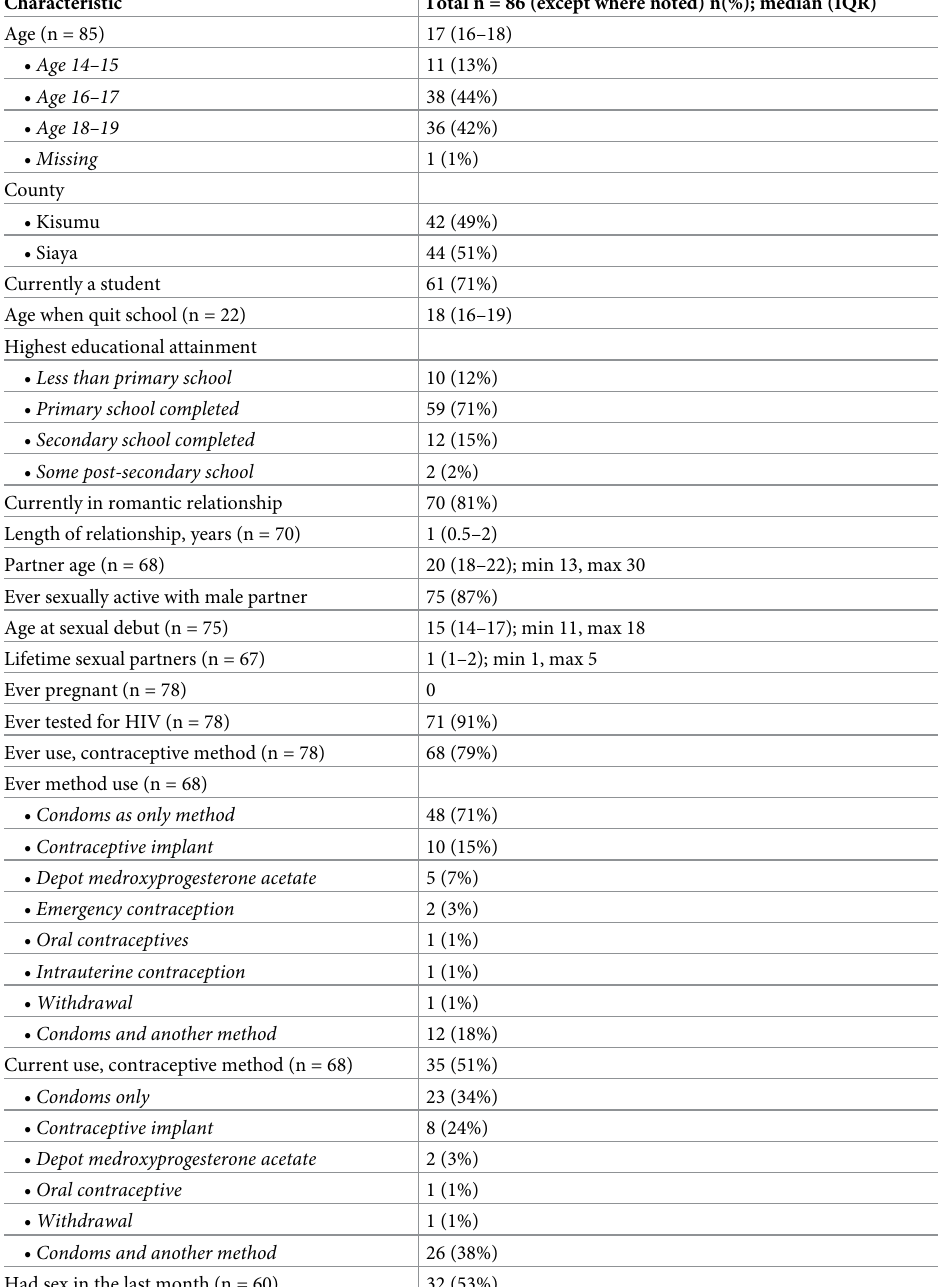
Table 1. Participant characteristics.